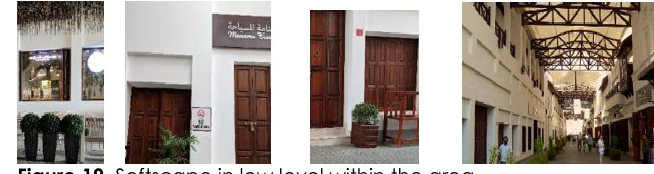
Figure 19. Softscape in low level within the area. Green was used as a concept while designing open spaces in old time. Many types and forms in term of palms and species of shrubs were used. as main